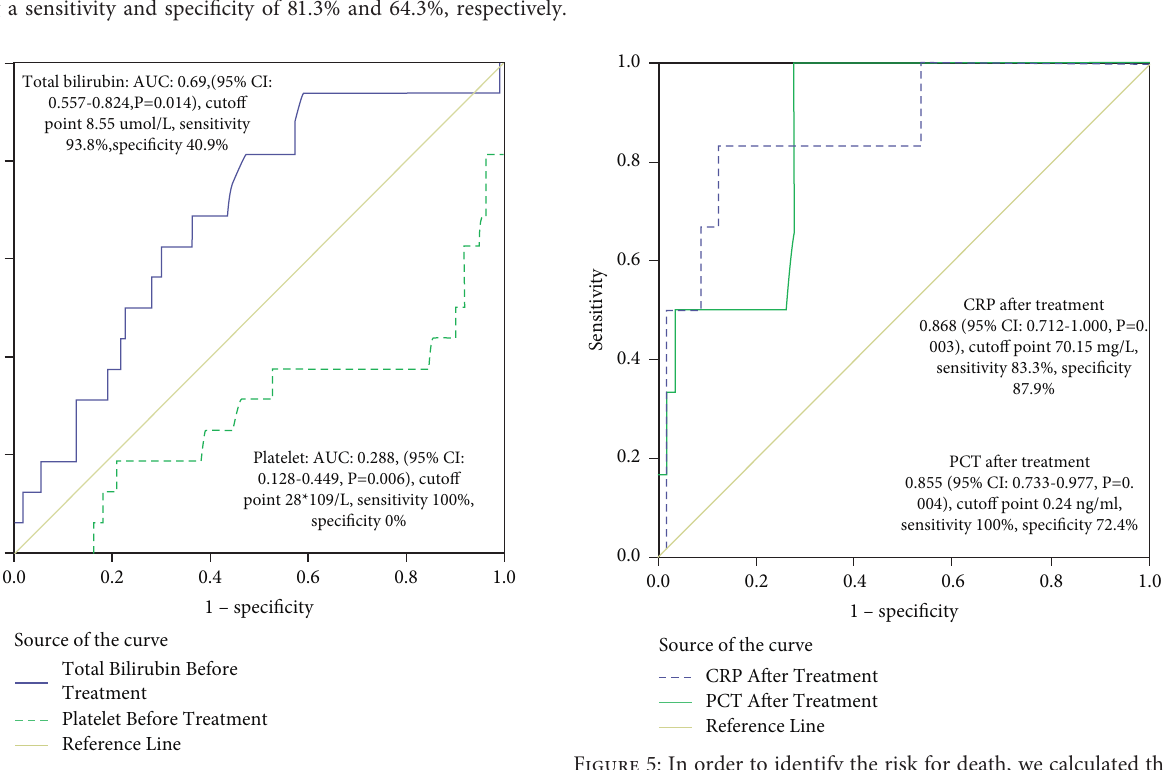
Figure 4: ROC curves of serum total bilirubin and platelet resulted in an AUC of 0.69 (95% CI: 0.557–0.824, p � 0 . 014) and 0.288 (95% CI: 0.128–0.449, p � 0 . 006), respectively, using a cutoff value of 8.55umol/L for serum total bilirubin with a sensitivity of 93.8% and specificity of 40.9%, and a cutoff value of 28 ( ∗ 10 9 /L) for platelet with a sensitivity and specificity of 100% and 0%.